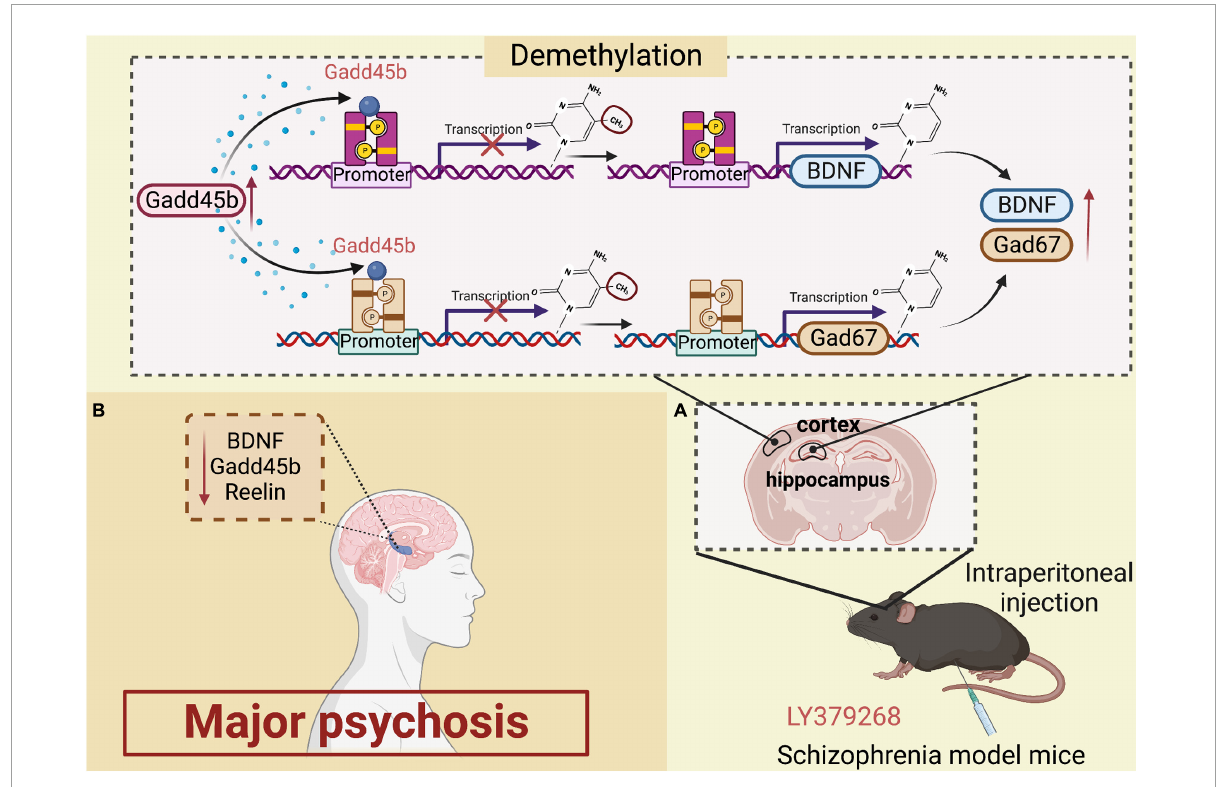
FIGURE2 Roles of growth arrest and DNA damage-inducible beta (Gadd45b) in major psychosis. (A) Increased expression of gadd45b in the hippocampal region is detected in schizophrenic mice after intraperitoneal injection of ly379268, which alters the Demethylation of BDNF and Gad67, increasing BDNF and Gad67 activation in large amounts. (B) Decreased Gadd45b, BDNF and Reelin expression in the brain of patients with major psychosis (Figure was created with